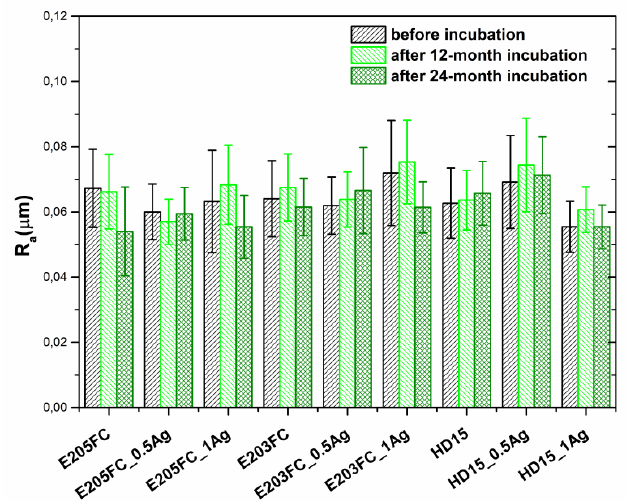
Figure 4. The arithmetical mean roughness ( Ra ) of pure polymers and polymers containing 0.5 wt % and 1.0 wt % of silver nanoparticles AgNPs. Statistical analysis showed no di ff erences ( p < 0.05) between materials before and after 12- and 24-month